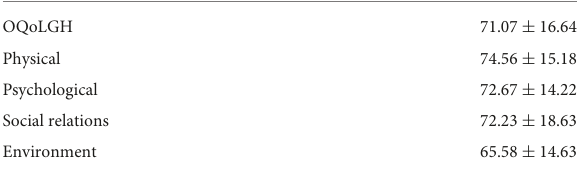
TABLE 2 Descriptive statistic of